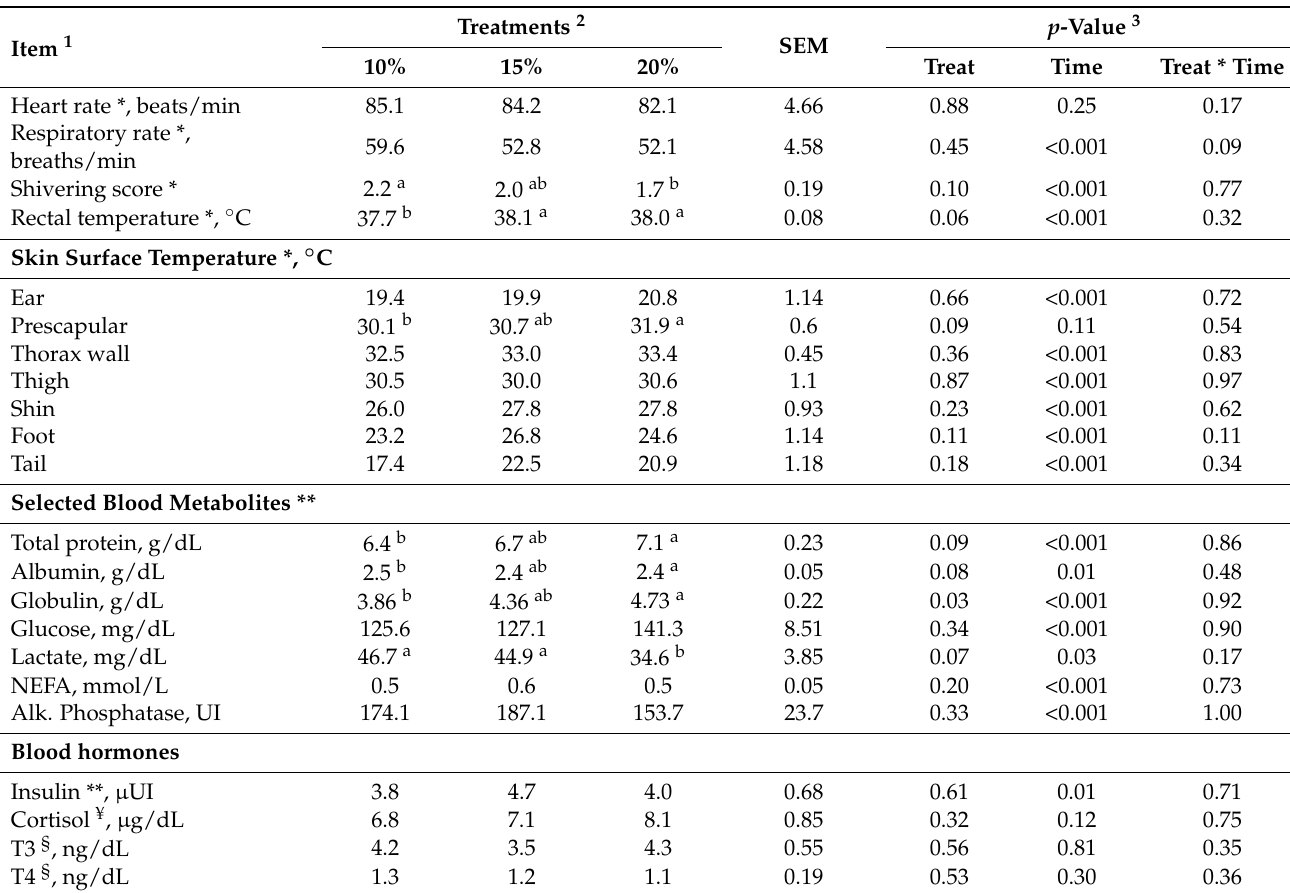
Table 1. Rectal and the skin surface temperature, heart and respiratory rates, shivering, and selected metabolites and blood hormones during the cold challenge of newborn calves fed different volumes of